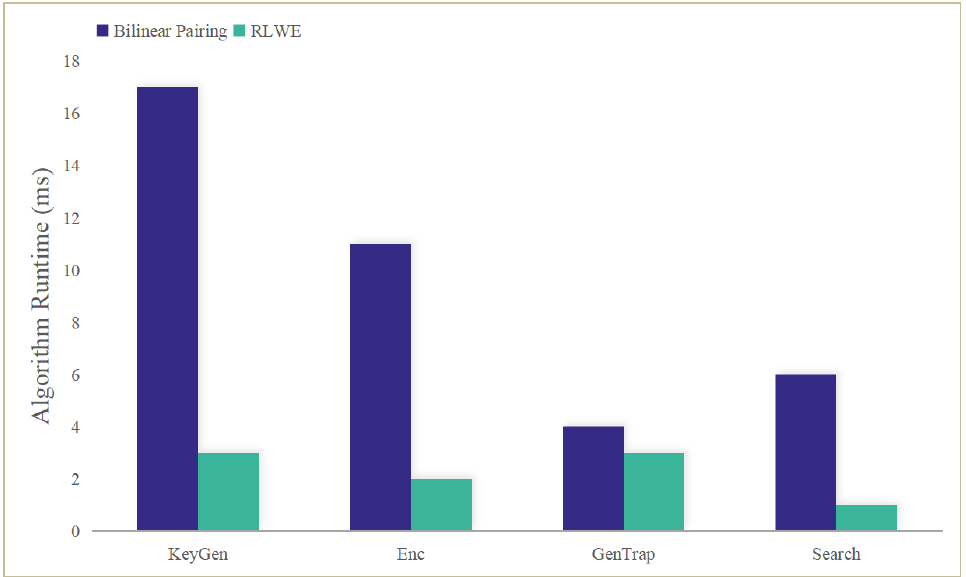
Figure 5. Reverse encrypted keyword index